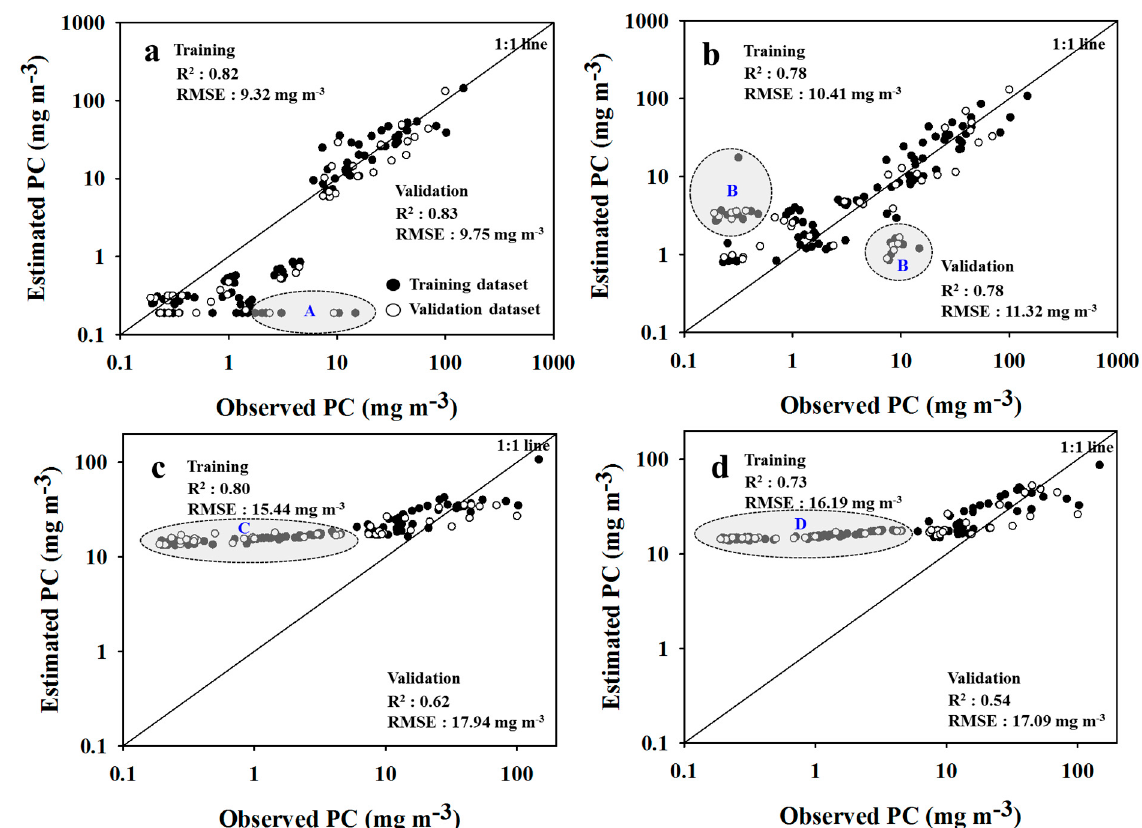
Figure 6. Training and validation results of PC estimation: ( a ) SAE-ANN, ( b ) ANN, ( c ) SAE-SVR, ( d ) SVR. Black and white dots represent training and validation results, respectively. Highlighted region of A-D indicates discrepancy in the estimated PC and Chl-a, compared to the observed ones.